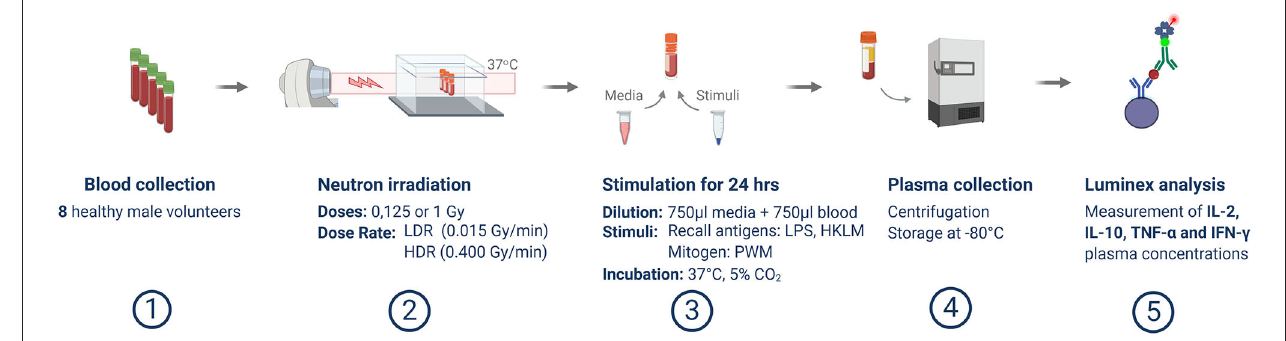
FIGURE 1 | Overview of experimental methodology. This schematic template illustrates the study process from blood sample collection, irradiation and stimulation, up to Luminex